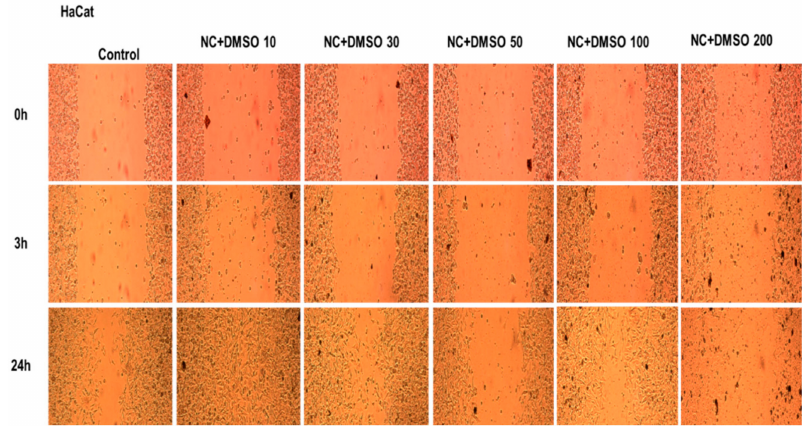
Figure 12. The e ff ect of di ff erent concentrations of NC solubilized in DMSO on human keratinocyte (HaCaT) migration and